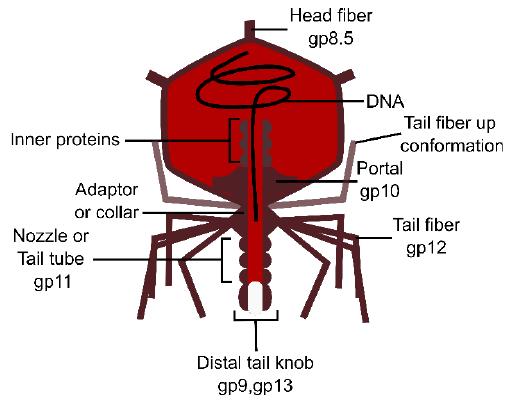
Figure 7. Schematic representation of podovirus Φ29 infecting B. subtilis . Gp numbers indicate the proteins involved in such structures in phage phi29. This figure was made with Inkscape.